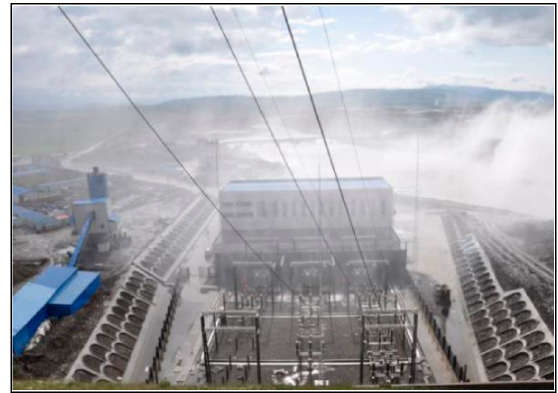
Figure 7. Prototype observation of powerhouse rainfall.